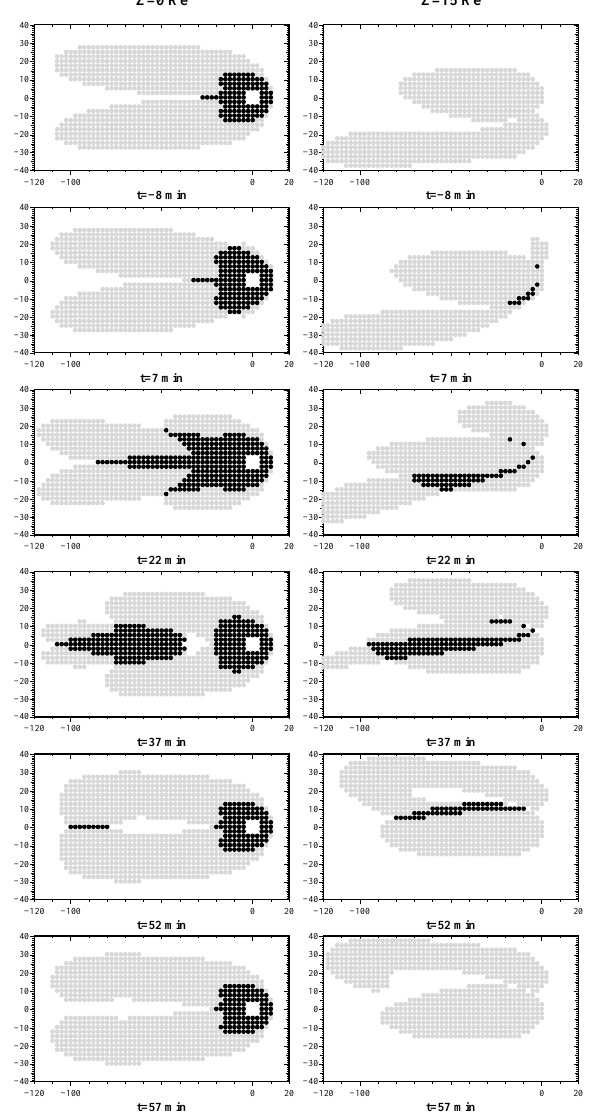
Fig. 7. Open (grey) and closed (black) field line region in the equa- torial plane (left column) and above it (right column) for different points of time during the fast IMF B y sign-change run (run